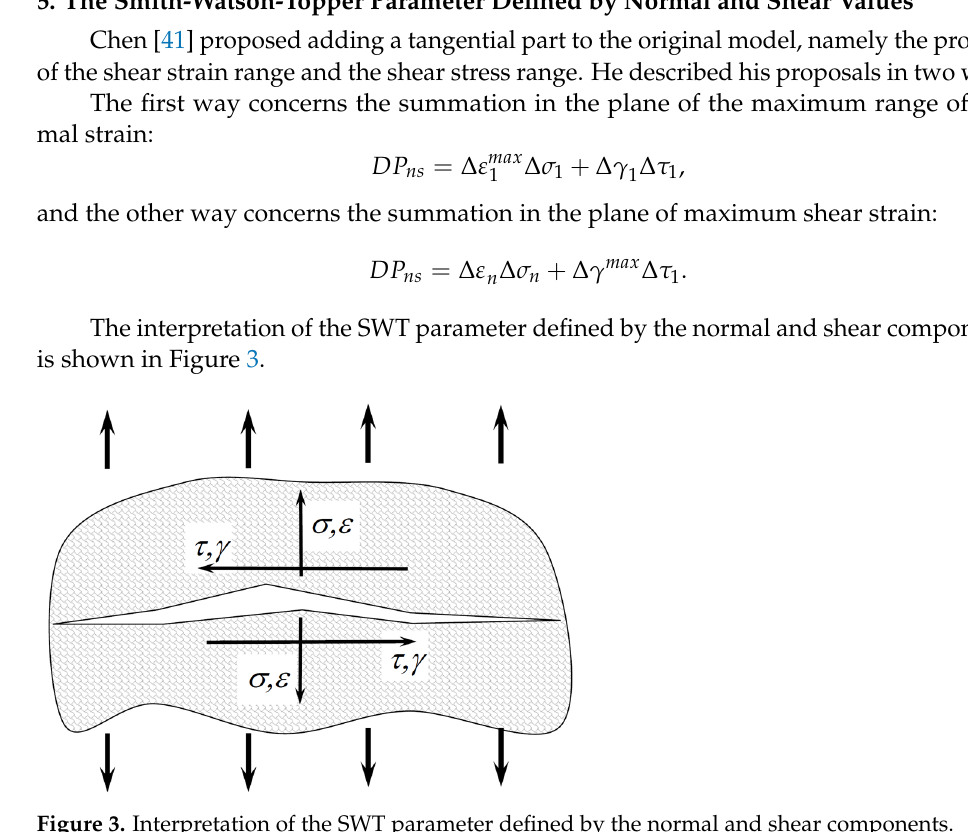
Figure 3. Interpretation of the SWT parameter defined by the normal and shear components.